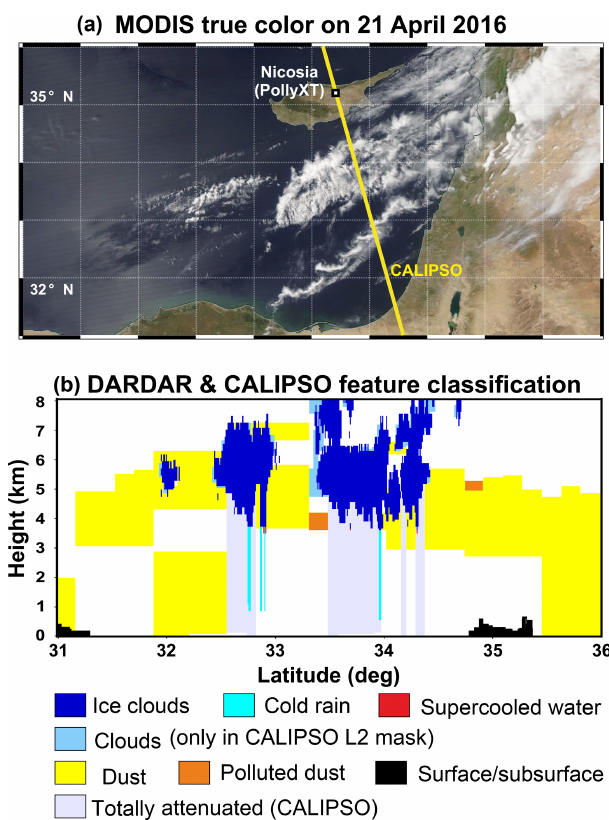
Figure 5. A-Train observations on 21 April 2016 at 11:00UTC of MODIS-Aqua true color from NASA Worldview Snapshots (a) and DARDAR and CALIPSO feature classification (b) .